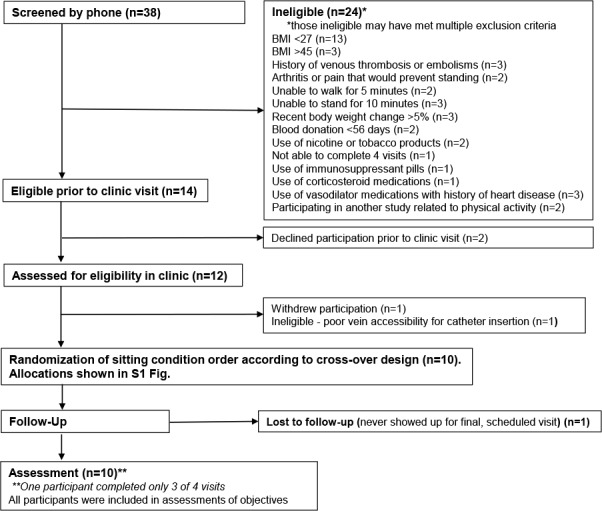
Consort diagram of enrollment and participation.